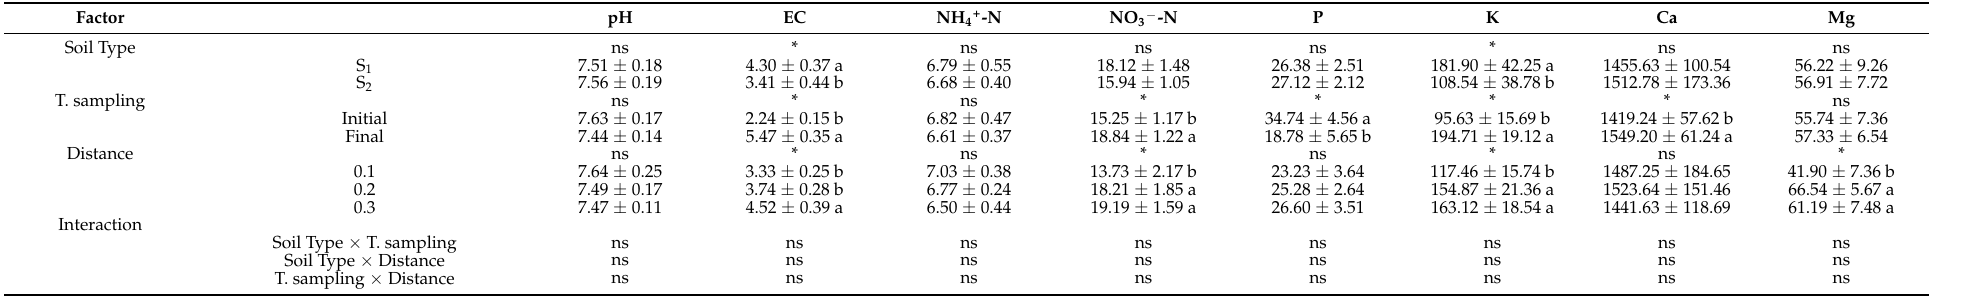
Table 2. Chemical parameters of sand layer (0–0.1 m) depending on the studied factors: (A) soil type, (B) T. sampling (time of sampling) and (C) distance from the emitter and their interactions. EC and nutrients concentration are expressed in dS m − 1 and mg kg − 1 , respectively.